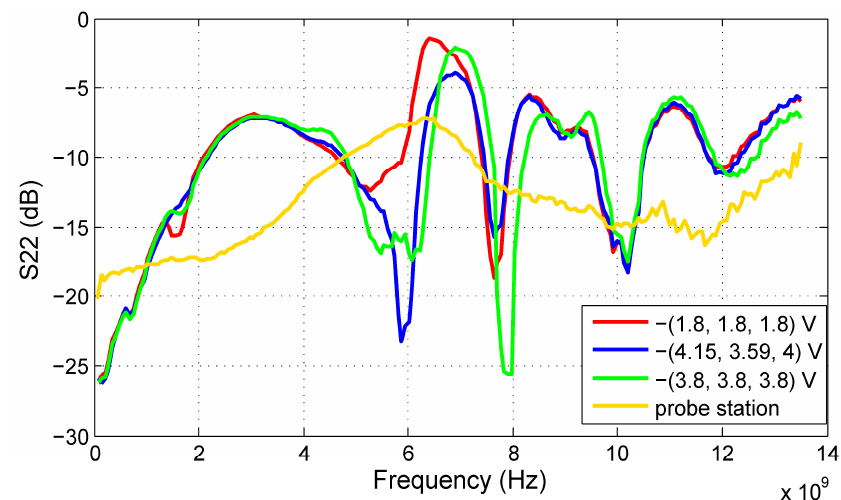
Figure 14. S22 of the proposed ECC bandpass filter.